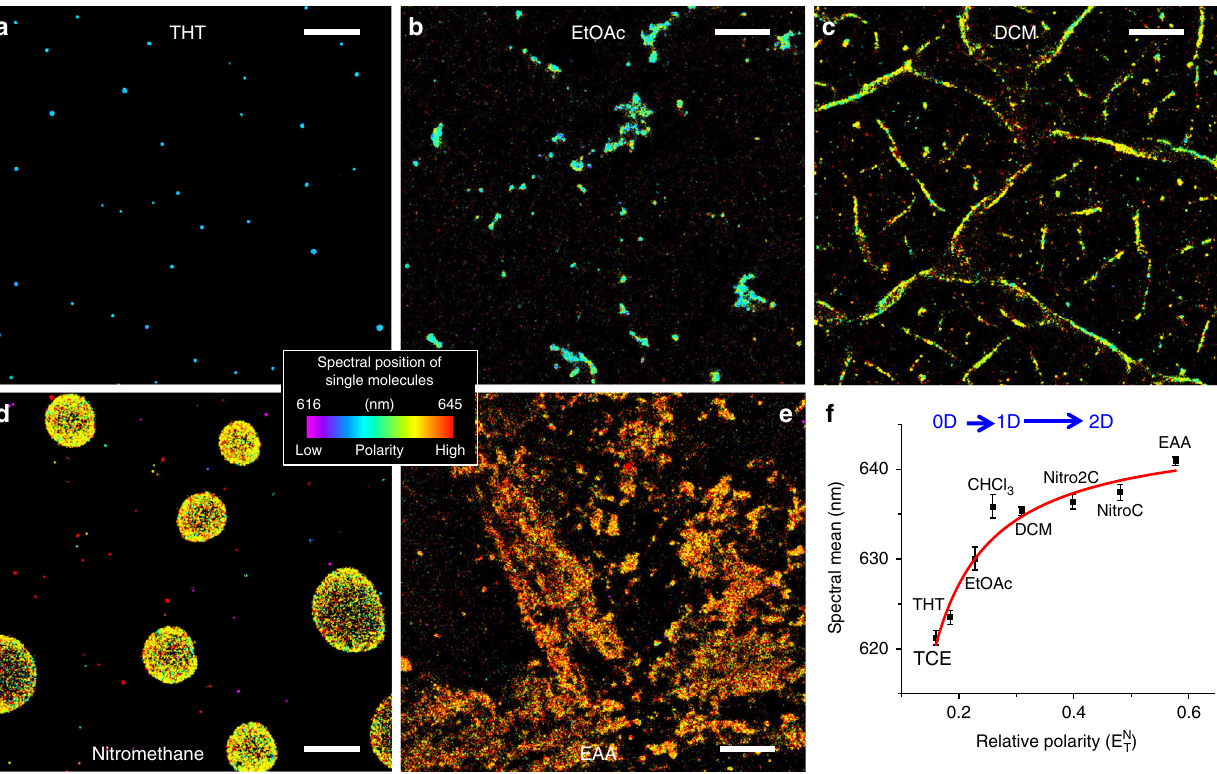
Fig. 3 Dependence of adlayer spectral and structural properties on polarity of the liquid. a – e True-color SR-PAINT images of adlayers of tetrahydrothiophene ( a ) ethyl acetate ( b ) dichloromethane ( c ) nitromethane ( d ) and EAA ( e ). Images were color-coded according to the spectral mean values of single Nile red molecules, on the same spectral/polarity scale as Fig. 2. Scale bars: 2 µ m. f Measured spectral mean values of the adlayers vs. the relative polarity (normalized Dimroth – Reichardt ET scale 30 ) of the liquids. THT: tetrahydrothiophene, EtOAc: ethyl acetate, DCM: dichloromethane, Nitro2C: nitroethane, NitroC: nitromethane. Each data point is averaged from 9 – 12 areas of 3 – 6 different samples, with standard deviations drawn as error bars. Red curve is a guide to the